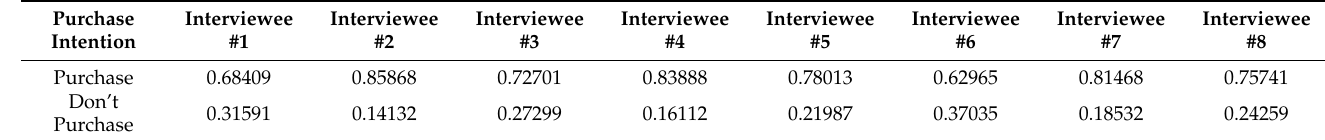
Table 17. Purchase intention of all Interviewees.